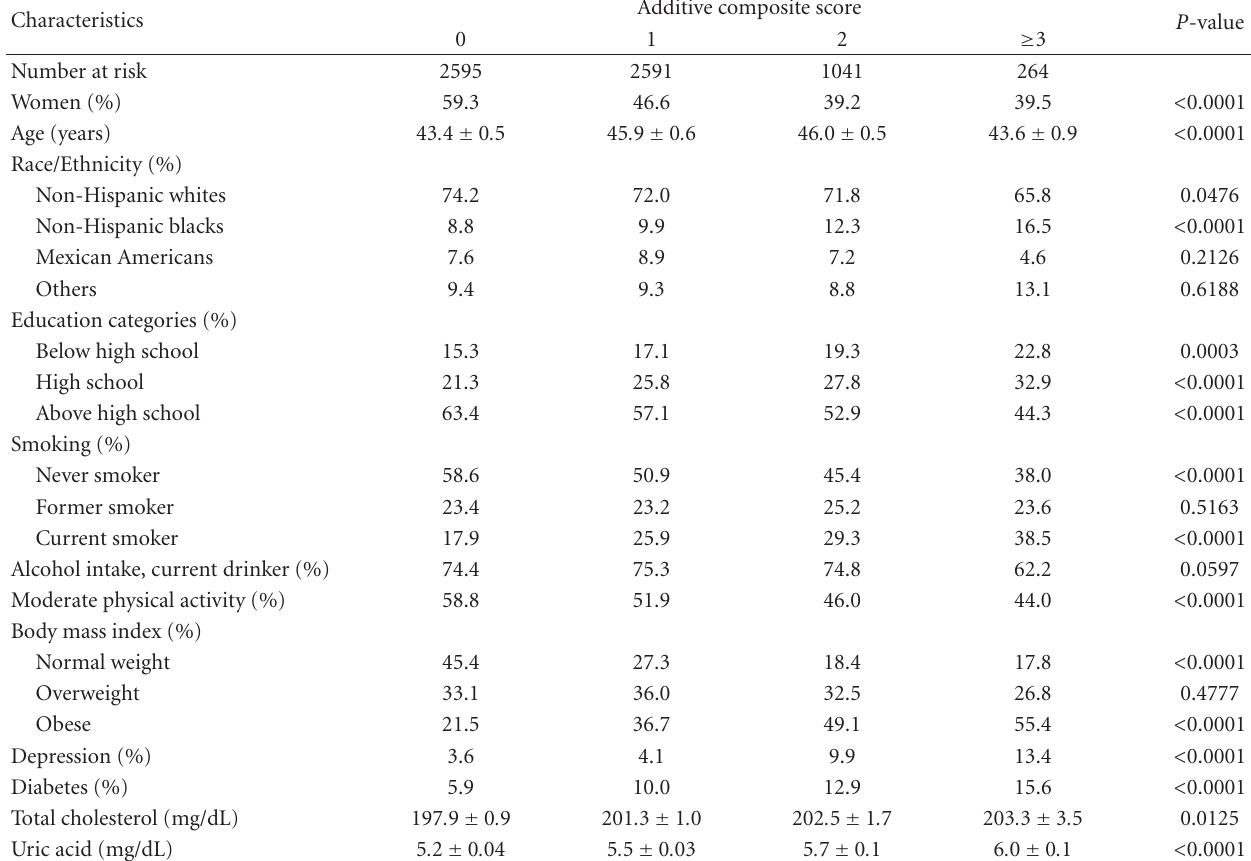
Table 1: Descriptive characteristics of the study population by categories of additive composite score ∗ .